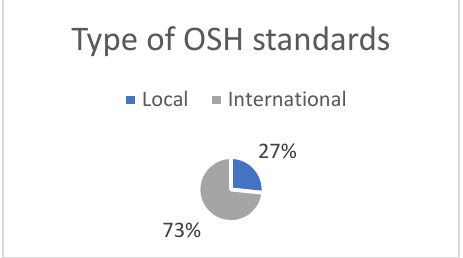
Figure 6. Type of OSH standards (own study).